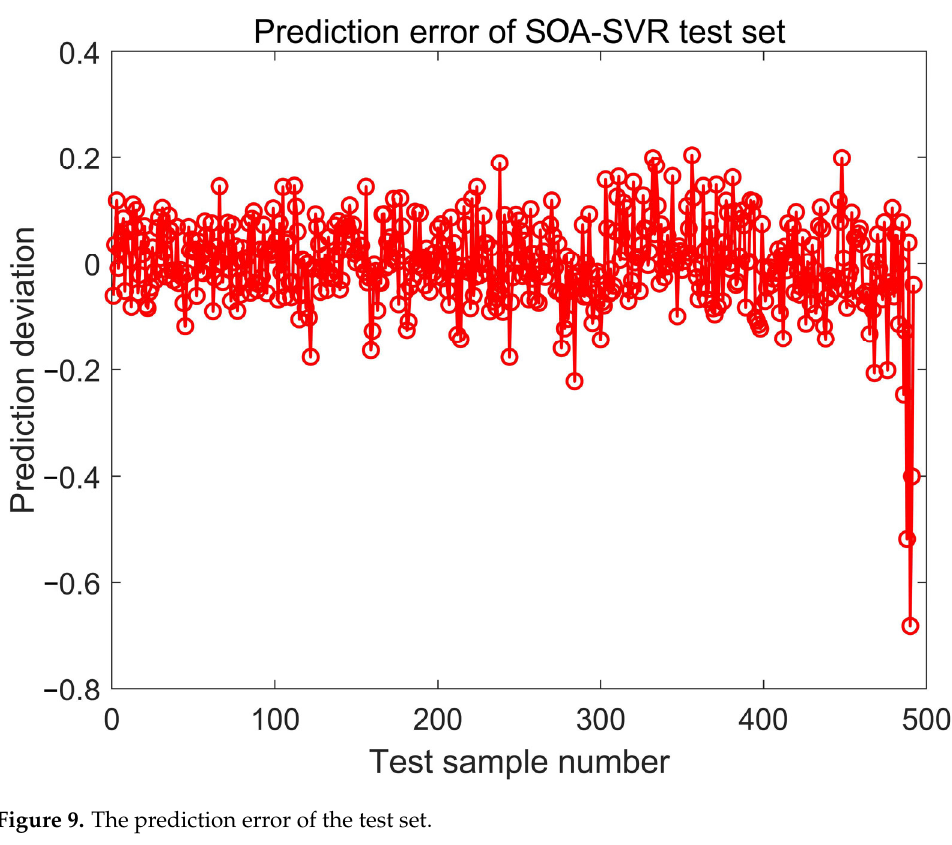
Figure 9. The prediction error of the test set.